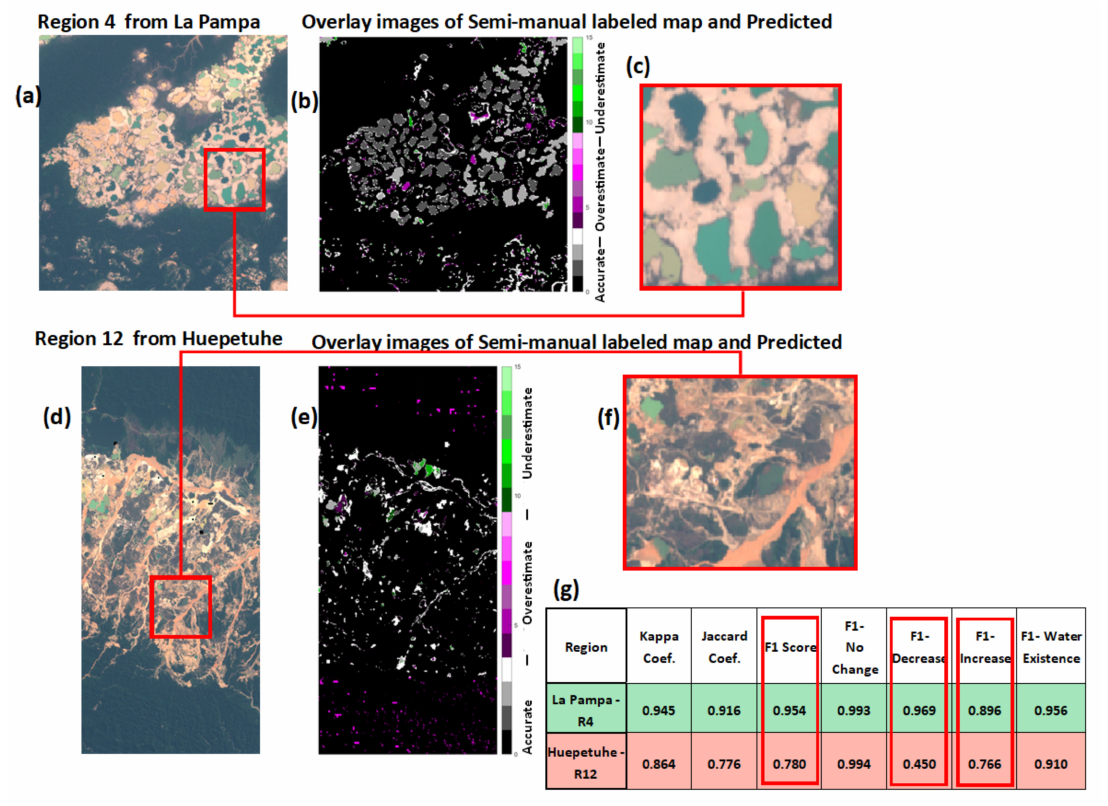
Figure 10. ( a ) True-color image composites of Region 4 in La Pampa ( b ) the overlay images of semi-manual label maps and model-predicted results of Region 4, ( c ) zoom in the ponds of Region 4, ( d ) True-color image composites of Region 12 in Huepetuhe ( e ) the overlay images of semi-manual label maps and model-predicted results of Region 12, ( f ) zoom in the ponds of Region 12, and ( g ) results table for two regions 4 and 12. These two different regions show how signatures of mining using different practices may generate more or less uniform surface water bodies. In ( b ) and ( e ), white and shades of gray represent accurate classification, shades of magenta represent overestimated sediment, shades of green represent underestimated sediment, and black represents no detected change. While Region 4 from La Pampa has deeper and more circular ponds that are separated by sand, Region 12 from Huepetuhe has more shallow, small and intricate ponds mixed with sand and bare ground, which appears to impact accuracy